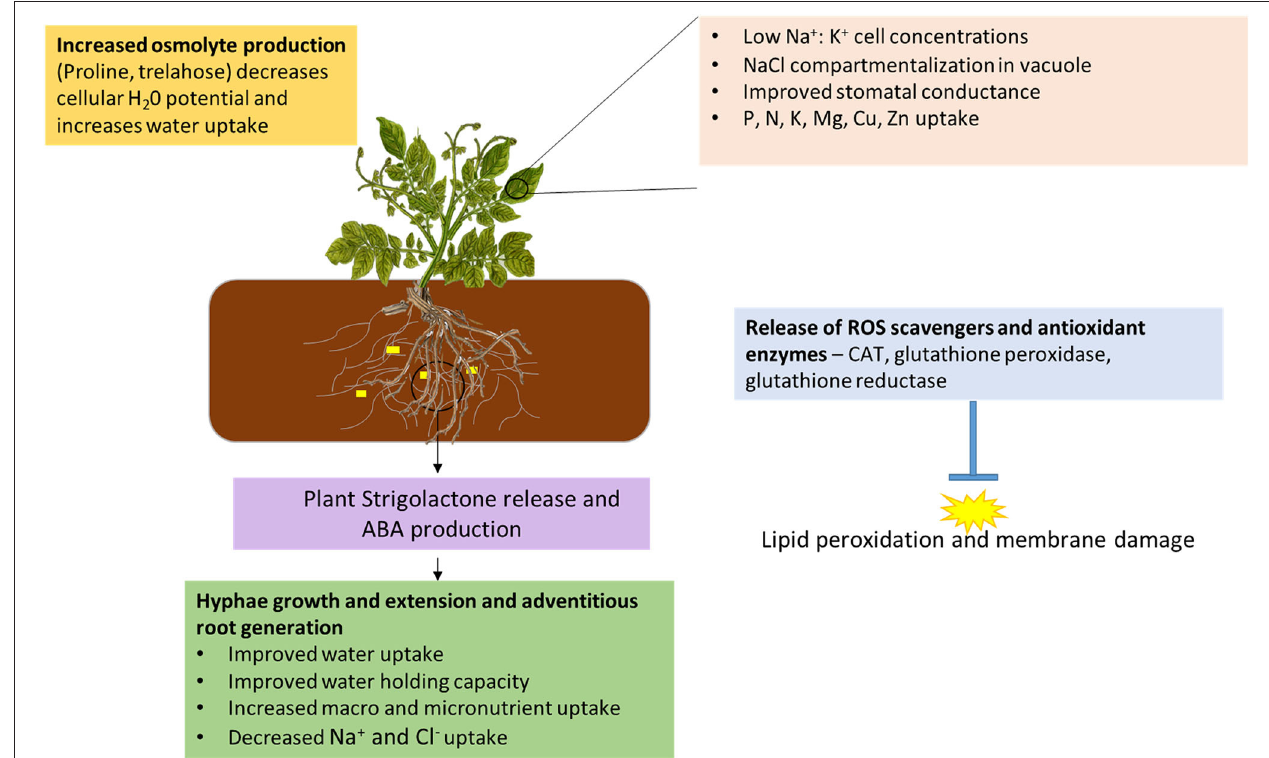
FIGURE 3 | AM fungi mediated crop tolerance to drought and salinity. Upon drought and salinity perception in the root area, plants release strigolactone (yellow rectangles) which strengthens AM fungi-crop symbiosis. AM fungi induce ABA release by plants, which also strengthens AM fungal associations. The extending hyphae provide plants with water relief as well as nutrient uptake. Under saline conditions AM fungi further discriminate NaCl uptake. In both the roots and shoots, anti-ROS compounds and antioxidant enzymes are produced to maintain membrane integrity and stop protein, enzyme, and DNA damage, as well as alteration of plant metabolic processes. In the leaves, plants accumulate osmolytes, which lower plant osmotic potential and allow water movement from the soil into the plant. Nutrient accumulation and improved stomatal conductance increase photosynthesis and therefore plant biomass. The plant cells are also capable of compartmentalizing NaCl to reduce salinity induced